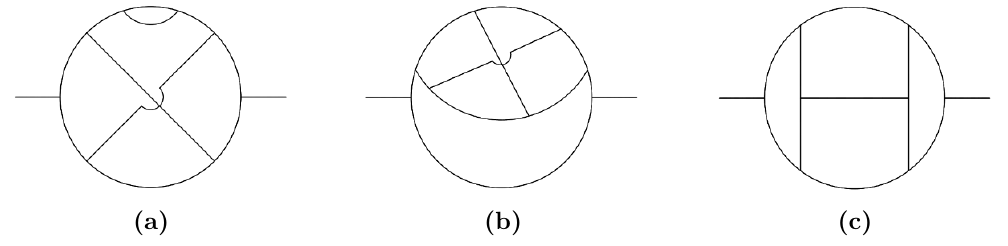
Figure 9. Non-trivial quantum corrections to the self-energy at four